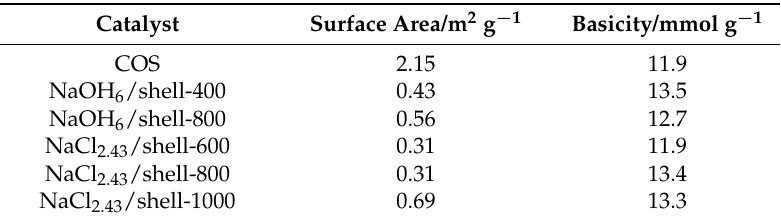
Table 1. The specific surface areas and basicities of COS, NaOH 6 /shell ‐ 400, NaOH 6 /shell ‐ 800,